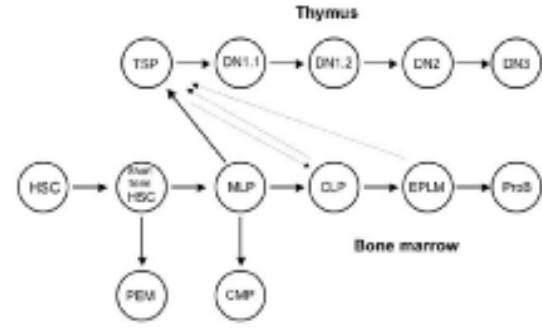
Figure 1 Current working model of haematopoietic